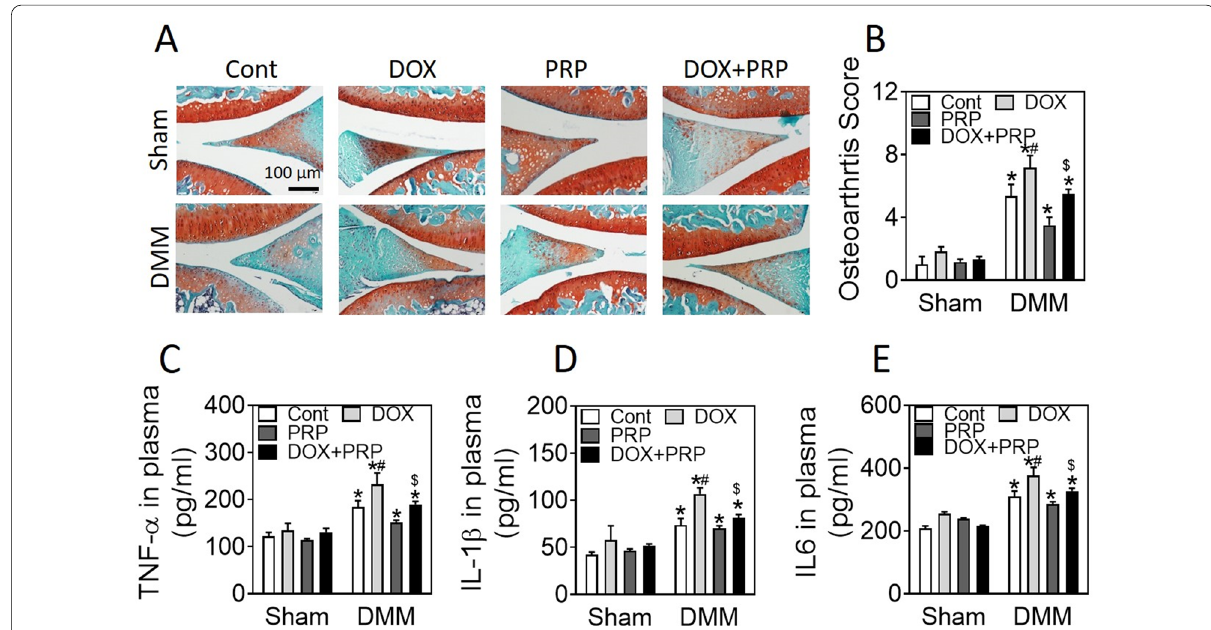
Fig. 1 PRP reduces doxorubicin exposure-increased susceptibility to osteoarthritis. The 12-week-old C57BL/6J mice were under DMM surgery for 1 week and received doxorubicin (10 mg/kg) injection and/or intra-articular injection of 15 μL PRP every week. After 4 weeks, mouse knee joints were collected. A , B Representative images of Safranin O/fast green staining ( A ) and quantification ( B ). C – E Plasma levels of TNF-α ( C ), IL-1β ( D ), and IL6 ( E ). n 6. * p < 0.05, vs sham of the same treatment; # p < 0.05, vs control of the same DMM treatment; $ p < 0.05, vs doxorubicin of the same DMM =